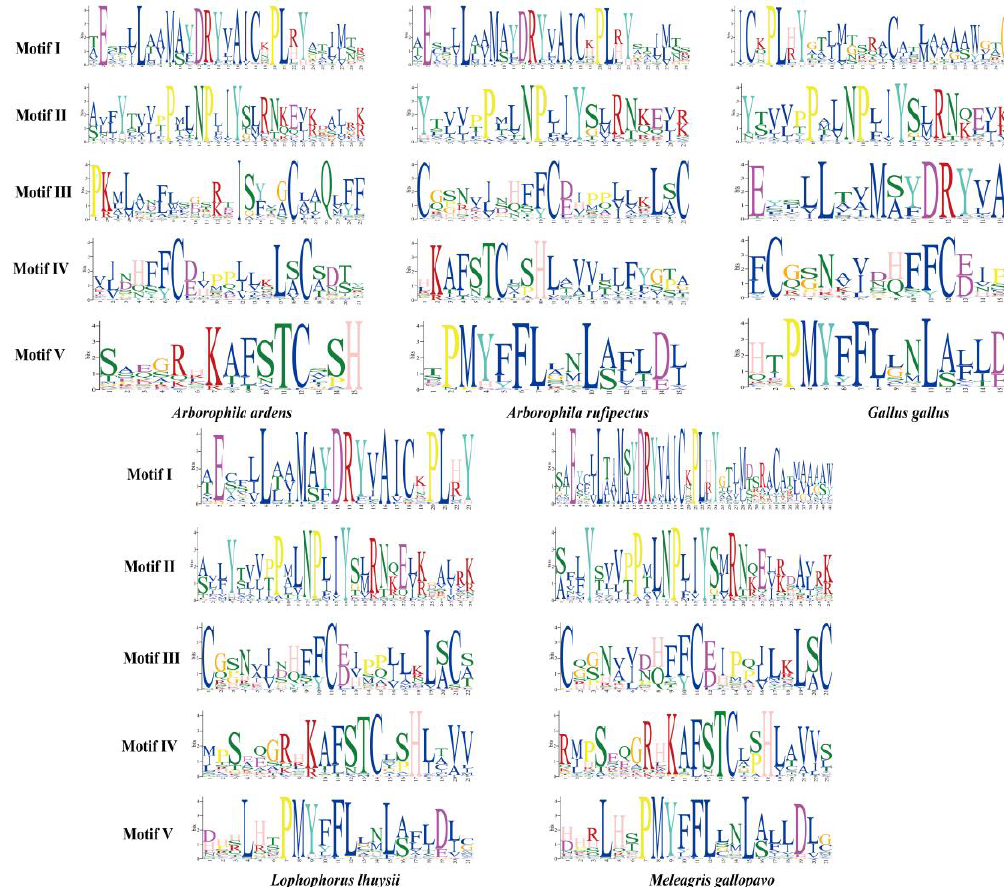
Figure 6. Logo representation of the five best conserved motifs identified for Phasianidae OR genes. The degree of conservation was represented by the height of the amino acid code.